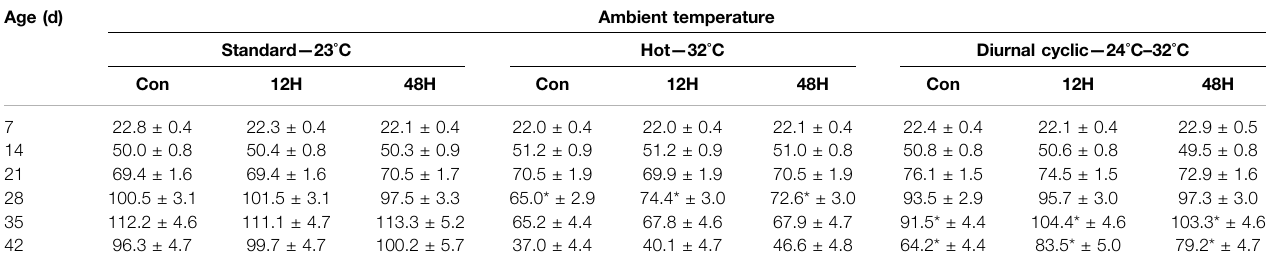
TABLE2| Weightgain(g/d)ofbroilersthatwereexposedtodifferenthypoxiaregimesduringembryonicdevelopmentandthenraisedunderdifferentenvironmentalambient temperatures (analyzed within each ambient